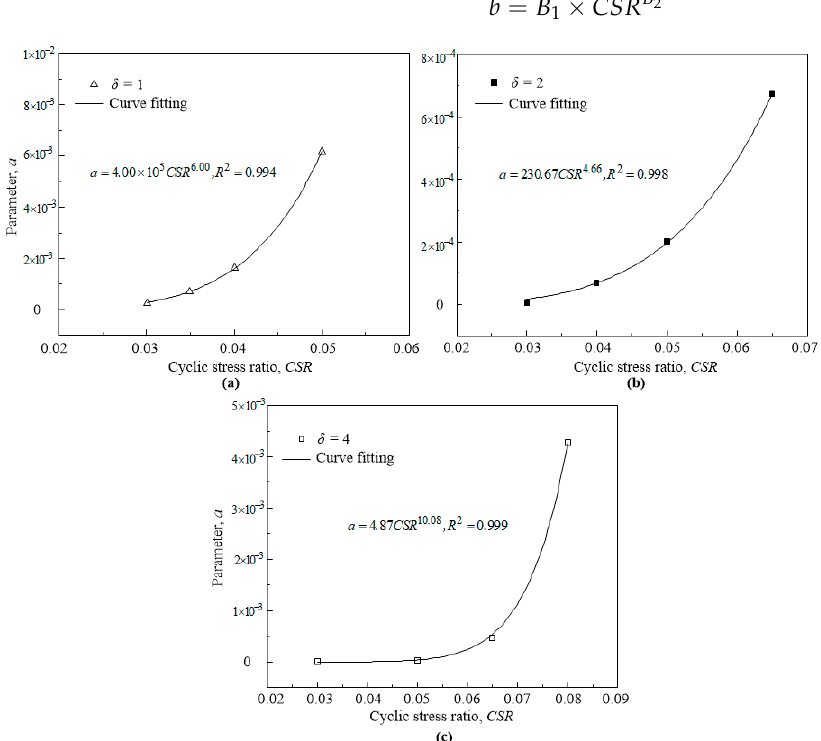
Figure 11. Relationship between parameter a and CSR in Monismith model. ( a ) The relationship between parameter a and CSR when δ = 1; ( b ) The relationship between parameter a and CSR when δ = 2; ( c ) The relationship between parameter a and CSR when δ = 4.